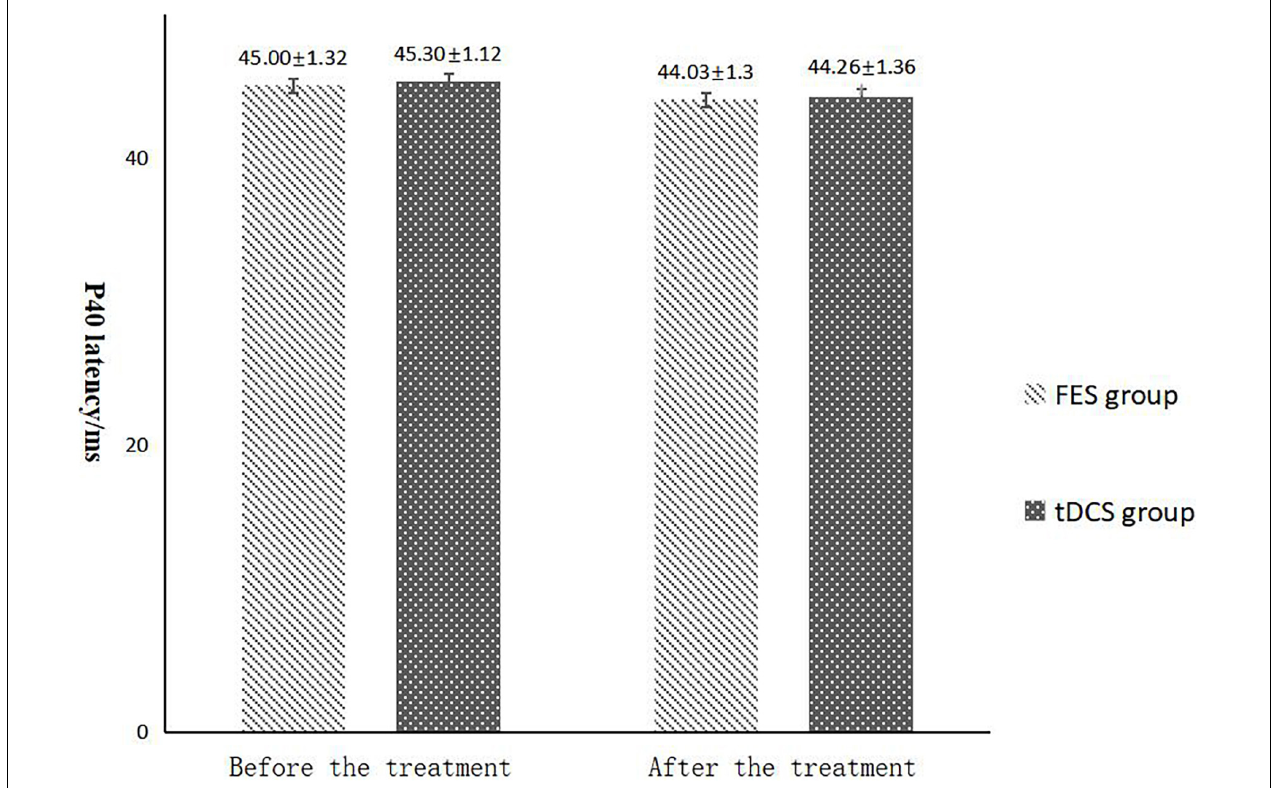
FIGURE 4 | P40 latency comparing improvement before and after FES and tDCS treatments in post-convalescent stroke patients. ∗ Indicates that the mean value of the tDCS and FES groups is significantly different at the same time point, p < 0.05. ∗∗ Indicates that the mean value of the tDCS and FES groups is significantly different at the same time point, p < 0.01. # Indicates that the mean score after treatment is significantly different from that before treatment, p <